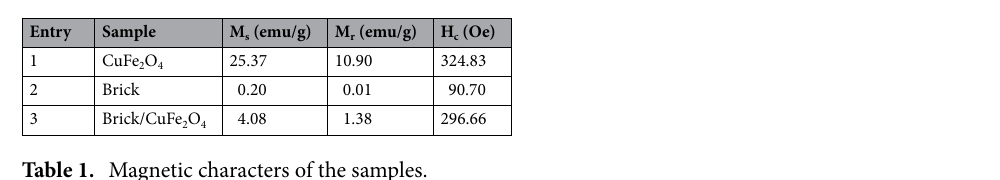
Table 1. Magnetic characters of the samples.